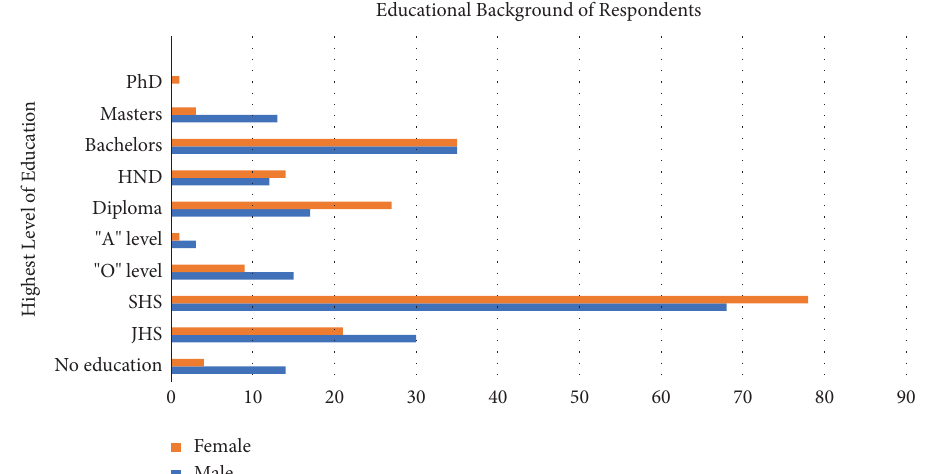
Figure 2: Educational background of the survey respondents in the Krowor municipality comparing gender diferences. Data represent the means for each group ( n � 400). (PhD: doctor of philosophy; HND: higher national diploma; SHS: senior high school; and JHS: junior high